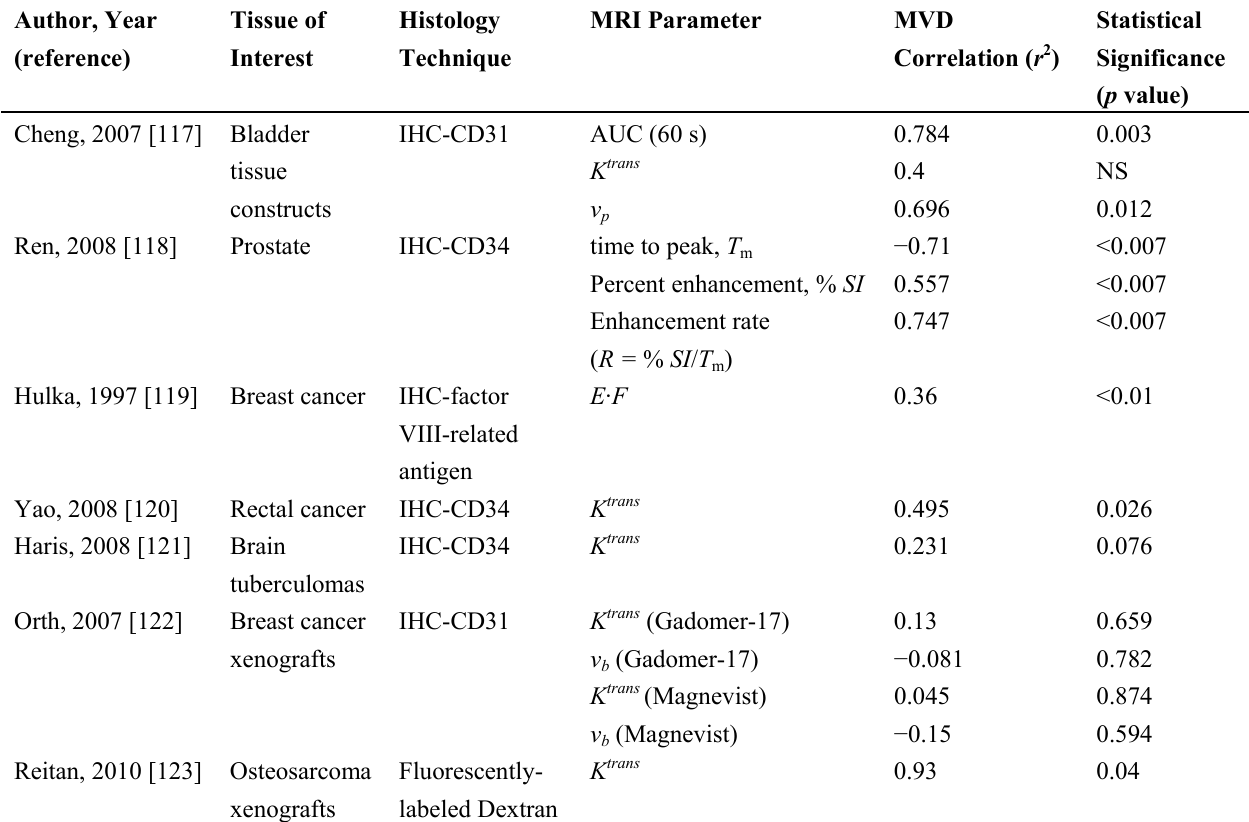
Table 3. Studies comparing DCE-MRI parameters, K trans and v assessments of microvessel